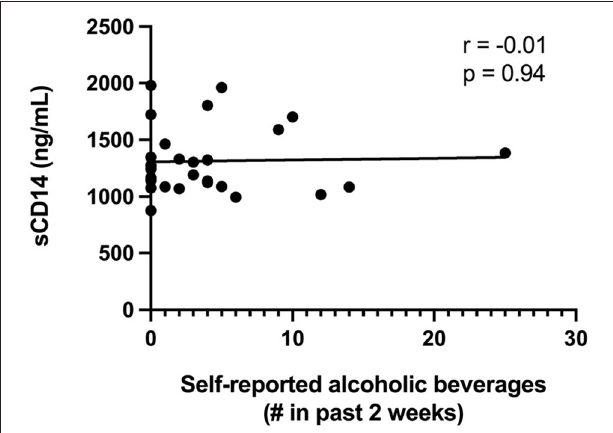
FIGURE 3 | Plasma sCD14 concentrations and self-reported alcohol intake. Plasma sCD14 concentration does not correlate with self-reported alcoholic beverage consumption in the past 2 weeks. The self-reported number of alcoholic beverages (past 2 weeks) was correlated with plasma levels of the monocyte activation marker sCD14, a validated indicator of gut integrity and microbial translocation. An alcoholic beverage was defined as 5oz glass of wine, a bottle or can of beer, or 1oz of hard